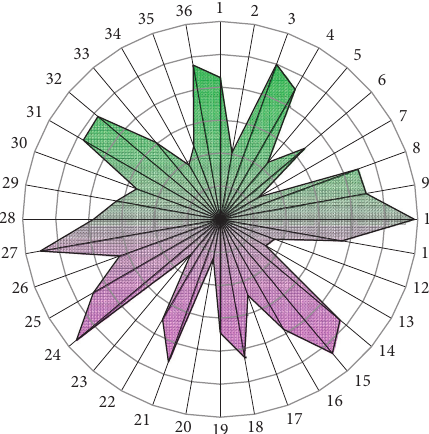
Figure 5: Overall evaluation of benchmarking early